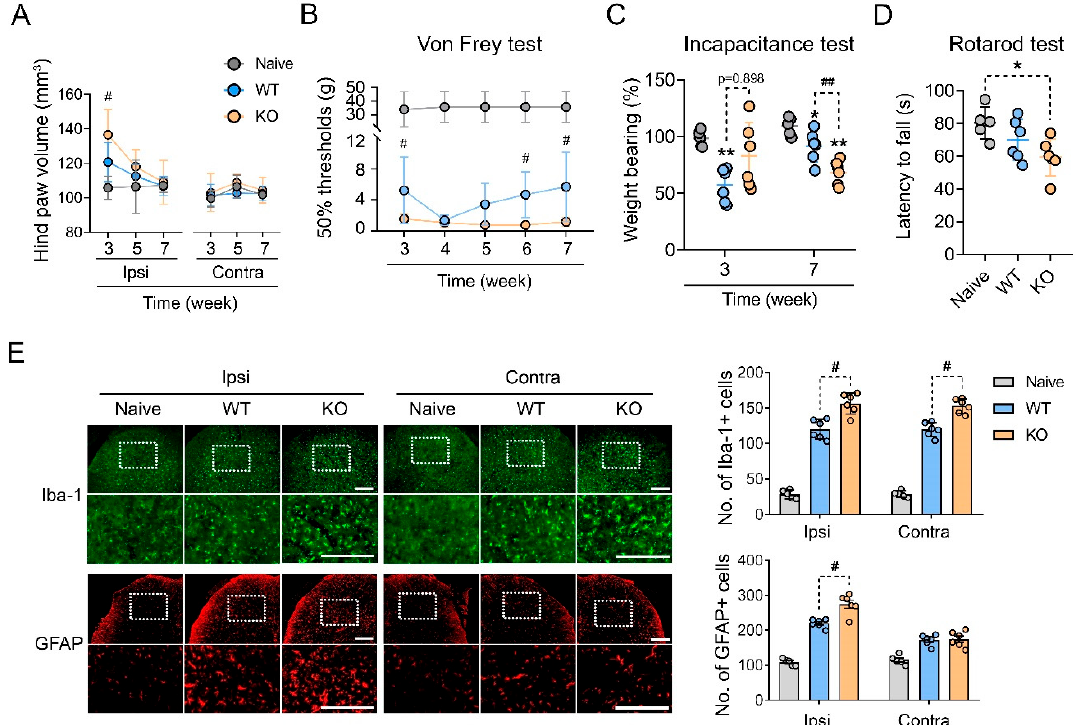
Figure 1. Loss-of-function of DICAM leads to severe pain-associated behavioral phenotypes in the tibia fracture and cast immobilization-induced CRPS model. ( A ) The volume of the ipsilateral (Ipsi) and contralateral (Contra) hind paws of DICAM KO mice and their WT littermates was measured at 3, 5, and 7 weeks postoperatively. n = 6 per group. ( B ) Mechanical allodynia was assessed using the von Frey test from the 3rd to 7th week in DICAM KO mice and their WT littermates. n = 6 per group. ( C ) The weight bearing on hind paw was assessed using the incapacitance test at the 3rd and 7th weeks. The weight bearing percent represents the ratio of the weight bearing of the ipsilateral and contralateral hind paws. Thus, any percentage <100% represented hind limb unweighting. n = 6 per group. ( D ) The rotarod was used to measure the locomotor capacity of CRPS mice at the 7th week. n = 3 per group. ( A – D ) * p < 0.05, ** p < 0.01 as compared with naïve mice, and # p < 0.05, ## p < 0.01 as compared with WT littermates by Mann–Whitney U test. ( E ) Representative figures of immunofluorescence staining for microglia (Iba-1; a microglial marker) and astrocytes (GFAP; an astrocyte marker) in the dorsal horn of the lumbar spinal cord of CRPS mice. The dashed area of upper panel was enlarged and displayed in the low panel. Scale bar indicates 1 µ m. Iba-1 and GFAP fluorescence-positive cells were quantified and expressed as the ratio to DAPI-positive cells. # p < 0.05 by Mann–Whitney U test. n = 4 per